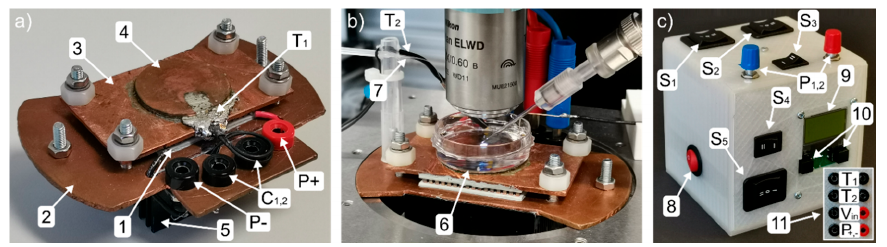
Figure 1. ( a ) Temperature-controlled sample holder: the sample holder consists mainly of a Peltier element (1), fixed between a lower copper plate (2) and an upper copper plate (3), including a copper disc (4), to fit a 35 mm Petri dish. A heat sink (5) is mounted to the lower plate and a thermometer, T 1 , soldered to the copper disc. The Peltier element is electrically connected via P+ and P − . The thermometer is contacted with the two connectors, C 1,2 . ( b ) Sample holder inside the patch clamp setup: The bottom plate fits into the microscope table, which has enough space underneath to accommodate the heatsink. Thermometer T 2 is used to monitor the temperature of the bath solution inside a 35 mm Petri dish (6). Attached to thermometer T 2 is the feed line (7) of the fluid compensation system. ( c ) 3D printed housing for the controller parts: power switch (8), switches S 1 , S 2 , and S 3 , potentiometers P 1 and P 2 , display (9), buttons to change display settings (10), connectors on the backside (11).